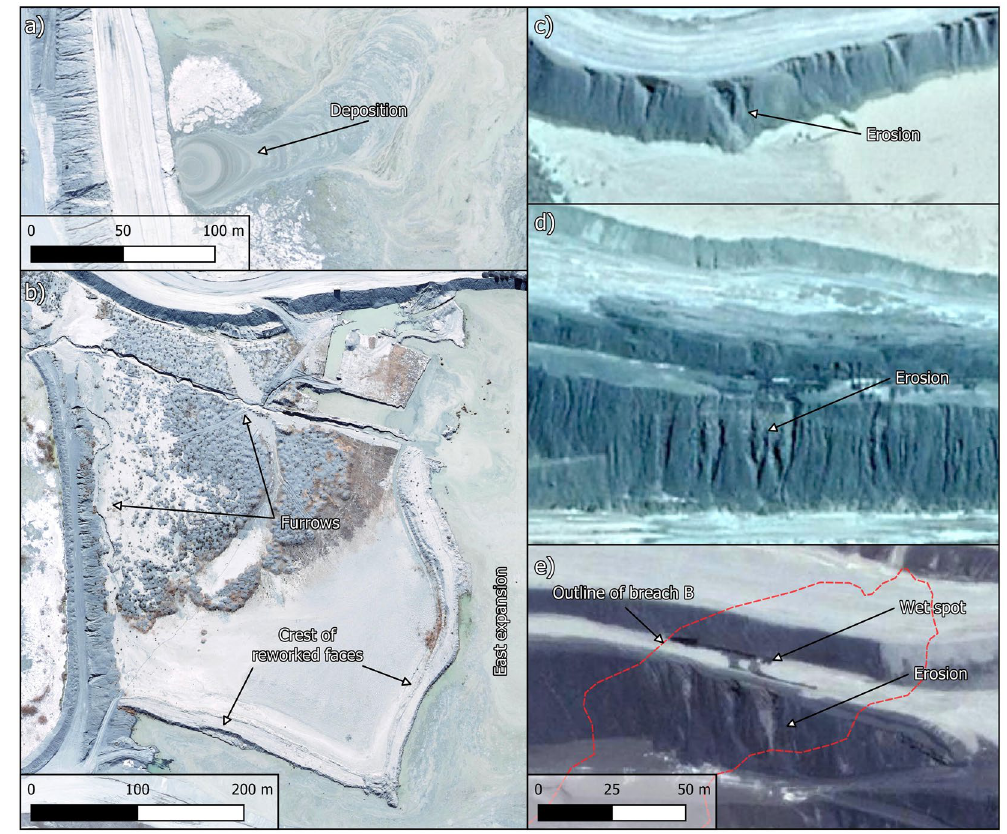
Figure 3. Details of the dam’s history. ( a ) Deposition into west expansion enlarged from Fig. 2d. ( b ) Furrows in original dam enlarged from Fig. 2d. ( c and d ) Erosion gullies enlarged from Fig. 2e. ( e ) Wet spot and